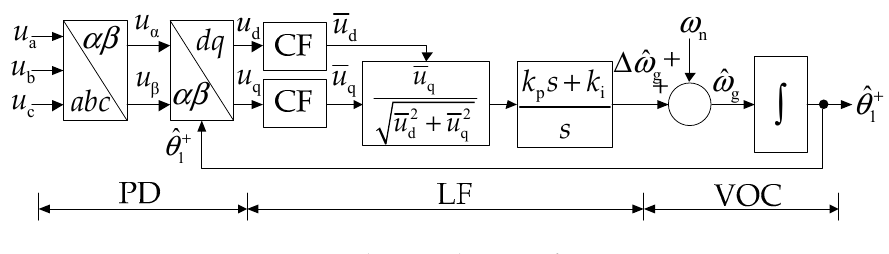
Figure 2. Schematic diagram of CF-PLL.